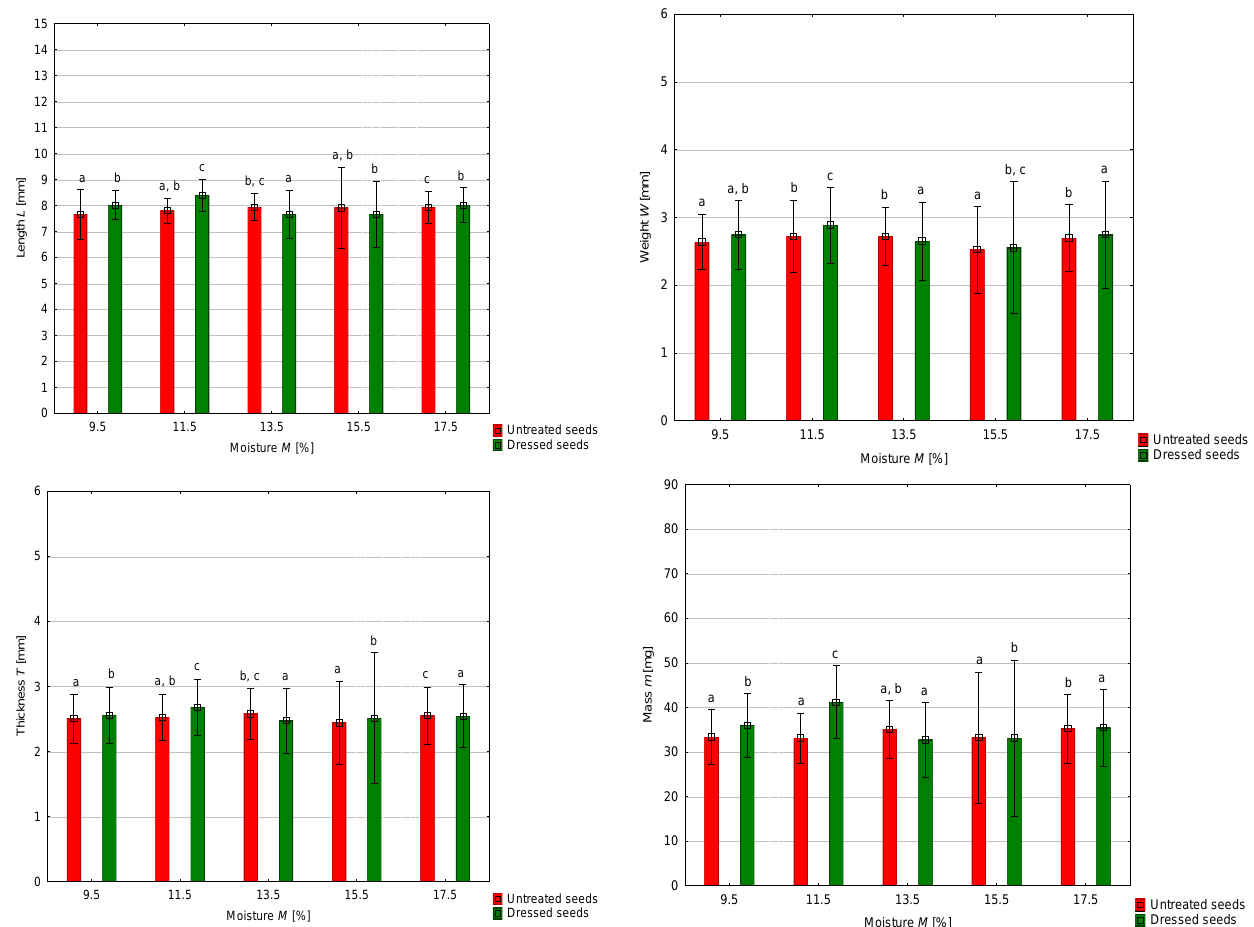
Figure 5. The physical parameters (the mean value and standard deviation) of winter rye seeds. Note: a, b, c—different letters indicate significant differences at p < 0.05 in the group of dressed and untreated seeds (Duncan’s test).